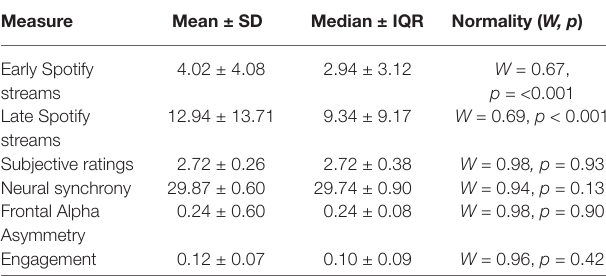
TABLE 1 | Descriptive statistics of included